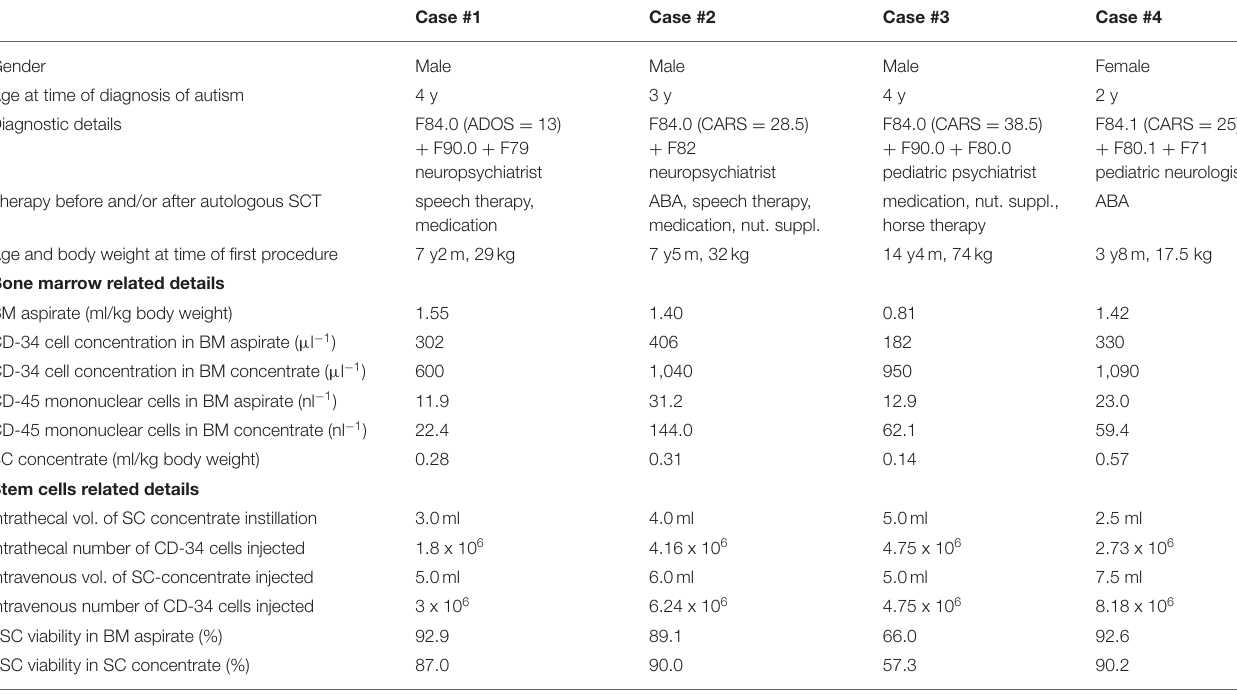
TABLE 1 | Demographic, diagnostic, and laboratory data and stem cell transplantation details of the four children with autism spectrum disorder